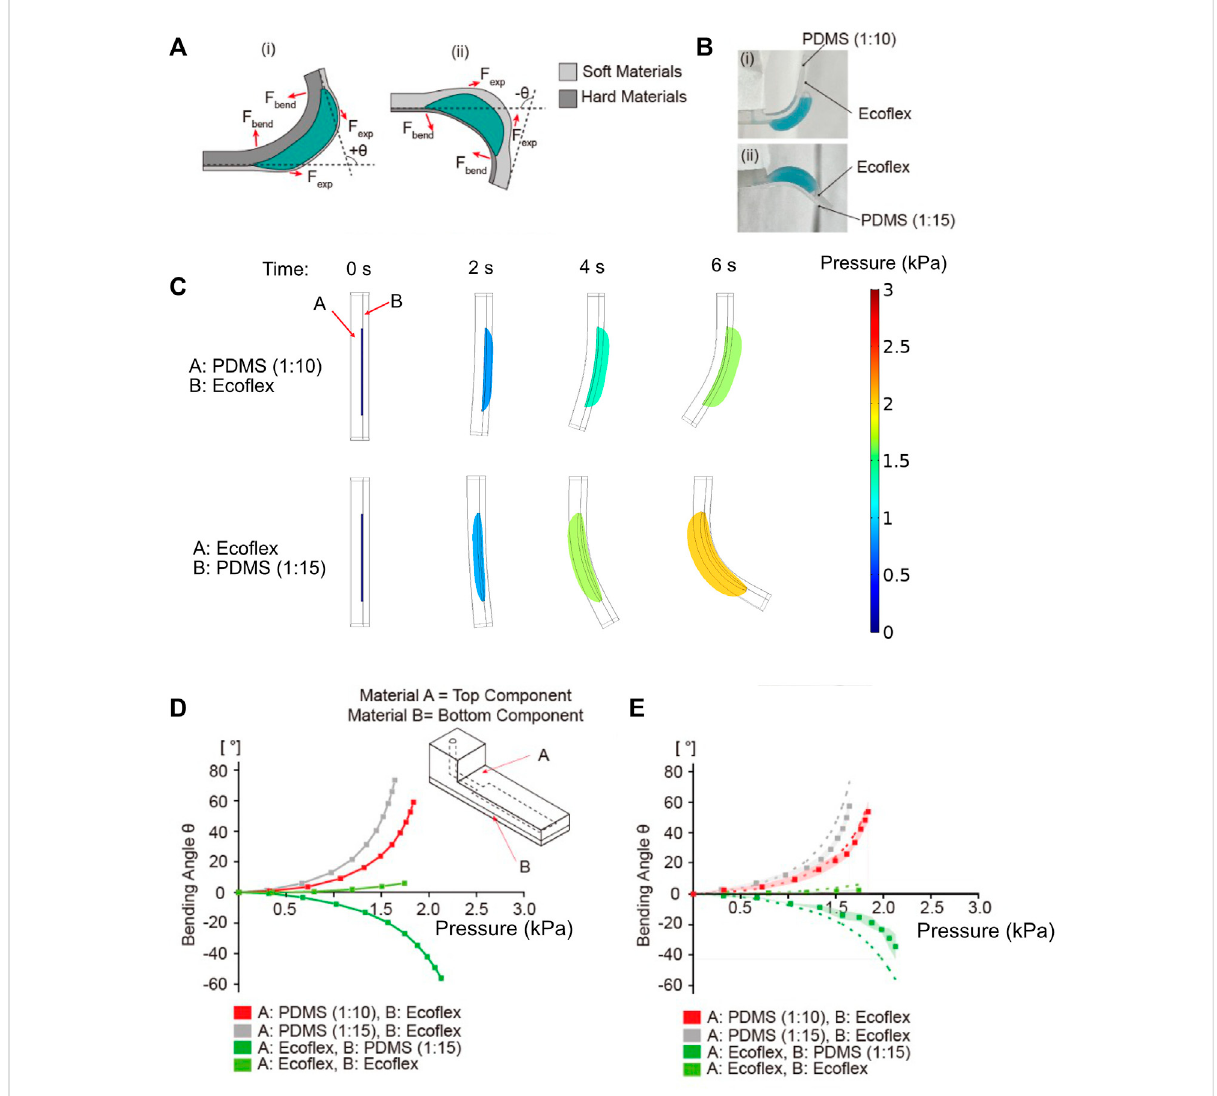
FIGURE 5 SimulationandexperimentalresultsforbendingangledependenceonthematerialsAandB. (A) Changeinbendingmotionduetodifferencein stiffness of materials A and B. (B) The experimental results of bending motion according to the stiffness of materials A and B: (i) When material B (expandablemembrane)wassofterthanmaterialA,theballoonactuatorbentupwardsand(ii)whenmaterialAwassofterthanmaterialB,the fl exible body (material A) underwent balloon expansion, causing reversed bending downward. (C) Images from COMSOL results showing the shape of actuators and the generated pressure at different time points. (D) Simulation results showing the bending angle as a function of in fl ation pressure. Various materials A and B of balloon actuator were tested (PDMS 1:10, 1:15, Eco fl ex 00-30) to verify the effect of material properties on bending angle. (E) Experimentalresults ofbending anglewith differentmaterialsAand B(PDMS 1:10,1:15,Eco fl ex00-30).Dots indicatetheaveragevalues of bending angle, and the shaded area represents the standard deviation of each data point. Dotted lines are the simulation results from (D)